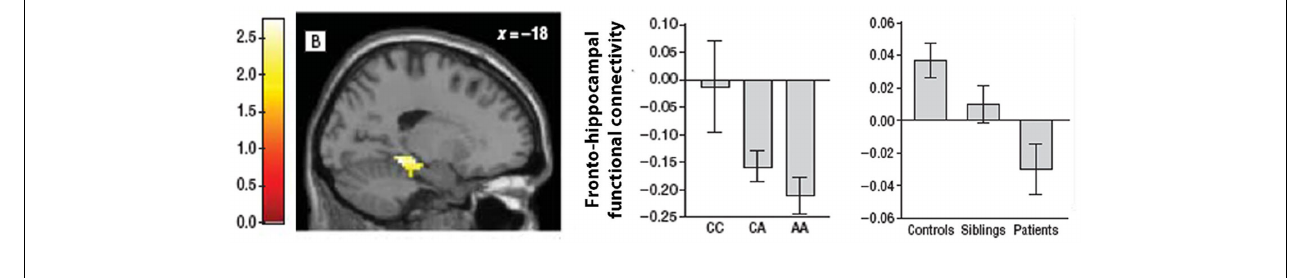
fronto-hippocampal functional connectivity as a function of ZNF804A in healthy controls (middle), and in controls, patients, and siblings (right). Carriers of the A risk allele showed an increasing trend toward greater negative functional connectivity, as did patients with schizophrenia. Image adapted from Rasetti et al.